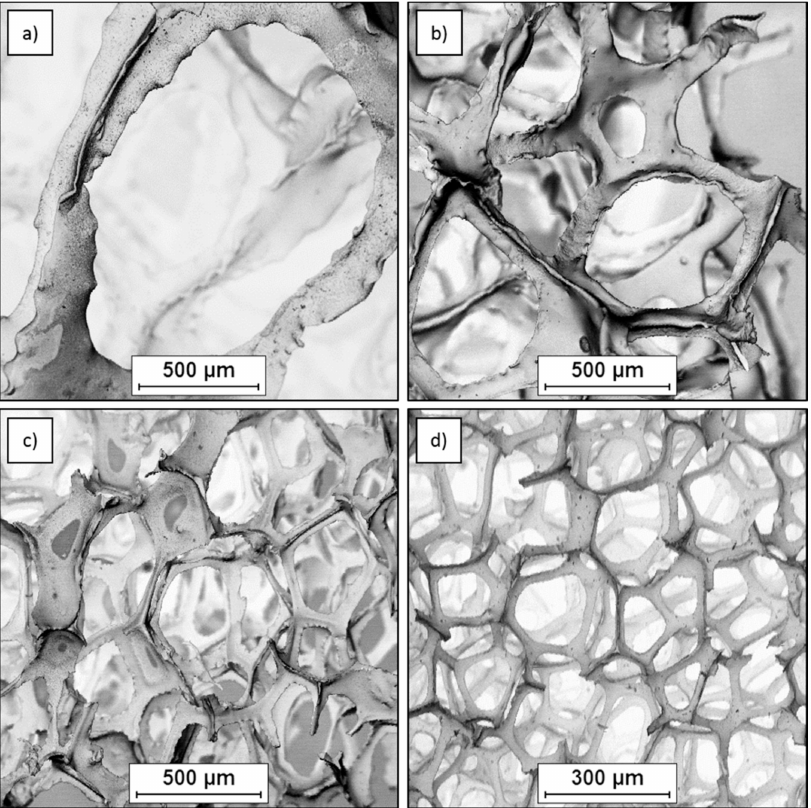
Figure 1. SEM micrographs of di ff erent cell size, open-celled carbon foams: ( a ) 10 ppi, ( b ) 20 ppi, ( c ) 45 ppi and ( d ) 100